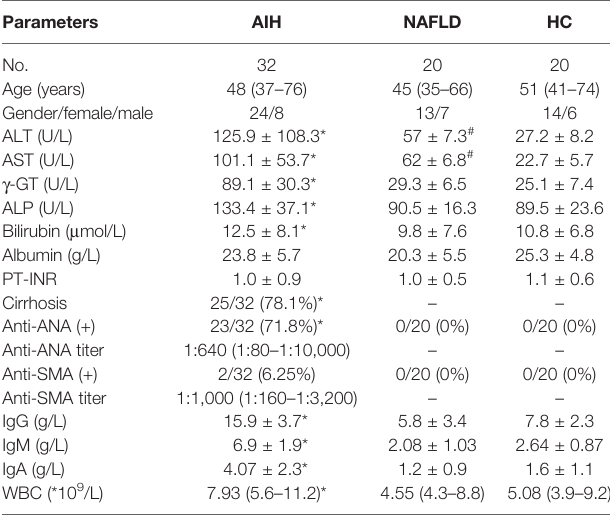
TABLE 1 | The demographic and clinical characteristics of